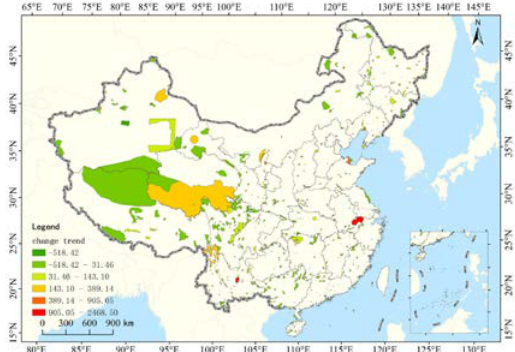
Figure 7. The change trend of TNL index of PAs across the national scale from 1992 to